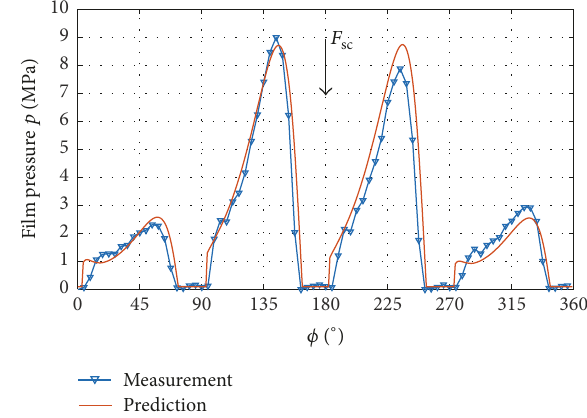
Figure 10: Measured [5, 6] and predicted pressure increase at leading edge of pad 4 (TPB500, 𝑄 = 420 l/min, and 𝑇 sup = 50 ∘ C).